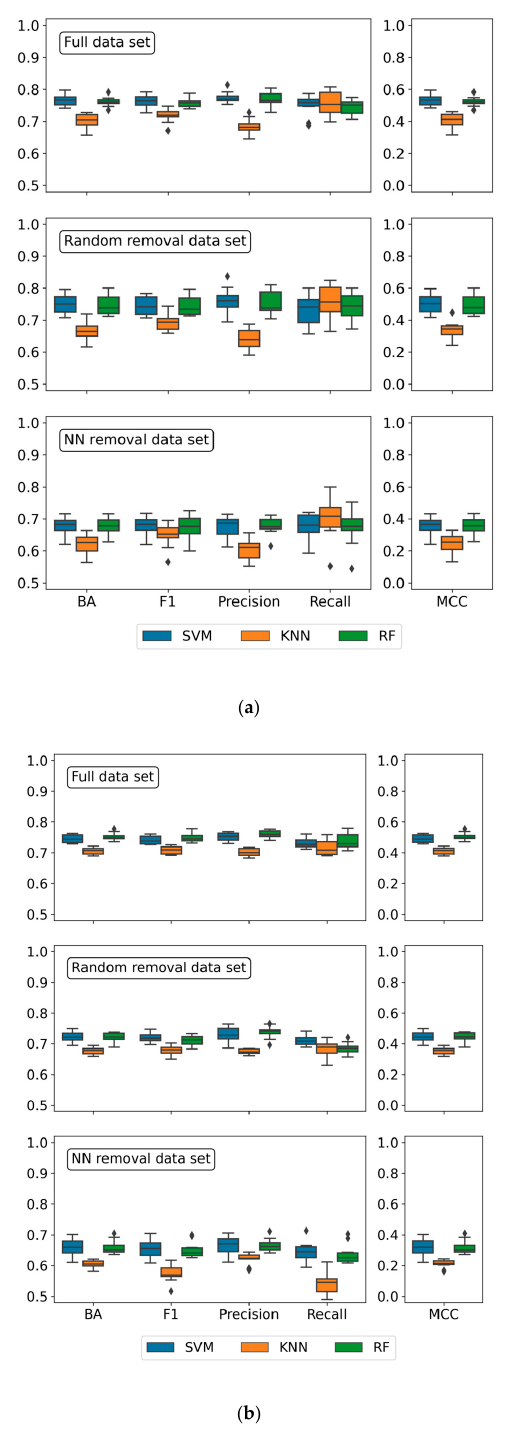
Figure 5. Comparison of prediction accuracies. In ( a , b ), prediction accuracies are shown for data sets from biochemical and mixed assays, respectively. Box plots report the distribution of balanced accuracy values for 10 independent SVM (blue), KNN (orange), and RF (green) trials using di ff erent training and test sets. From the top to the bottom, results are shown for all ST- and MT-CPDs (All CPDs), reduced data sets after random removal of 50% of the compounds (Random removal), and corresponding data sets after removal of 50% of NNs (NN